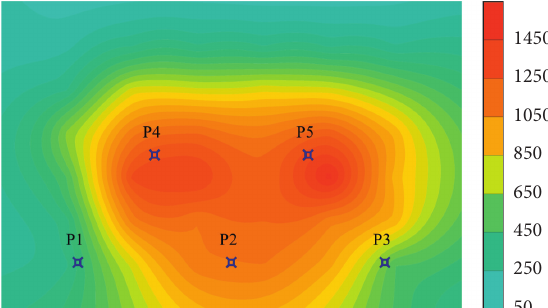
Figure 10: Polymer concentration field during binary flooding with weak edge water (0.6PV).